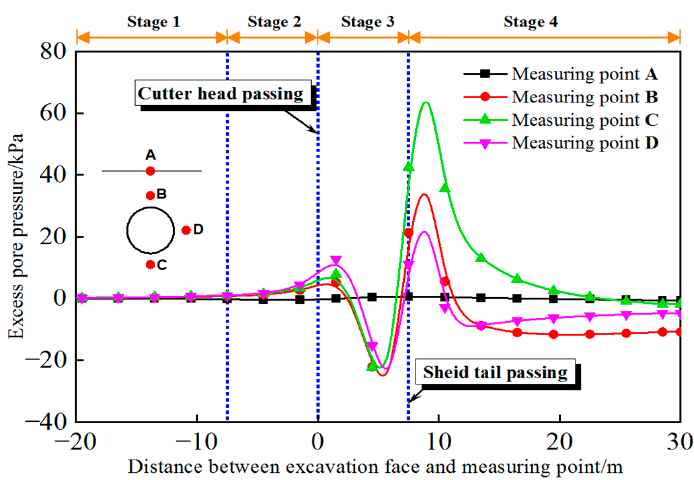
Figure 12. Excess pore water pressure development curves at monitoring points.